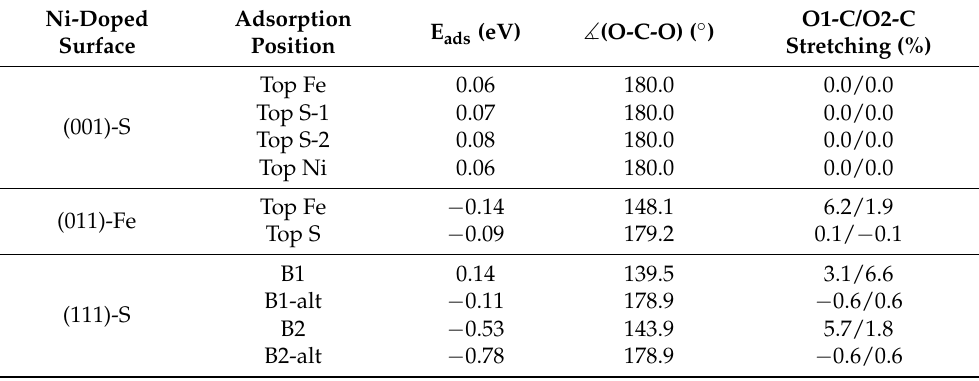
Table 3. Calculated adsorption energy (E ads ), CO 2 inner angle ( (cid:93) (O-C-O)), and O-C bond stretching (O1-C/O2-C) of a single CO 2 molecule adsorbed on various Ni-doped surfaces of FeS